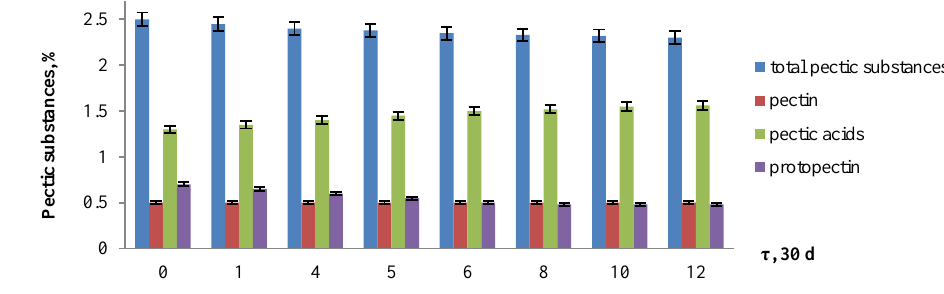
Fig. 5. Pectic substances content of dates during storage at −18 °C.